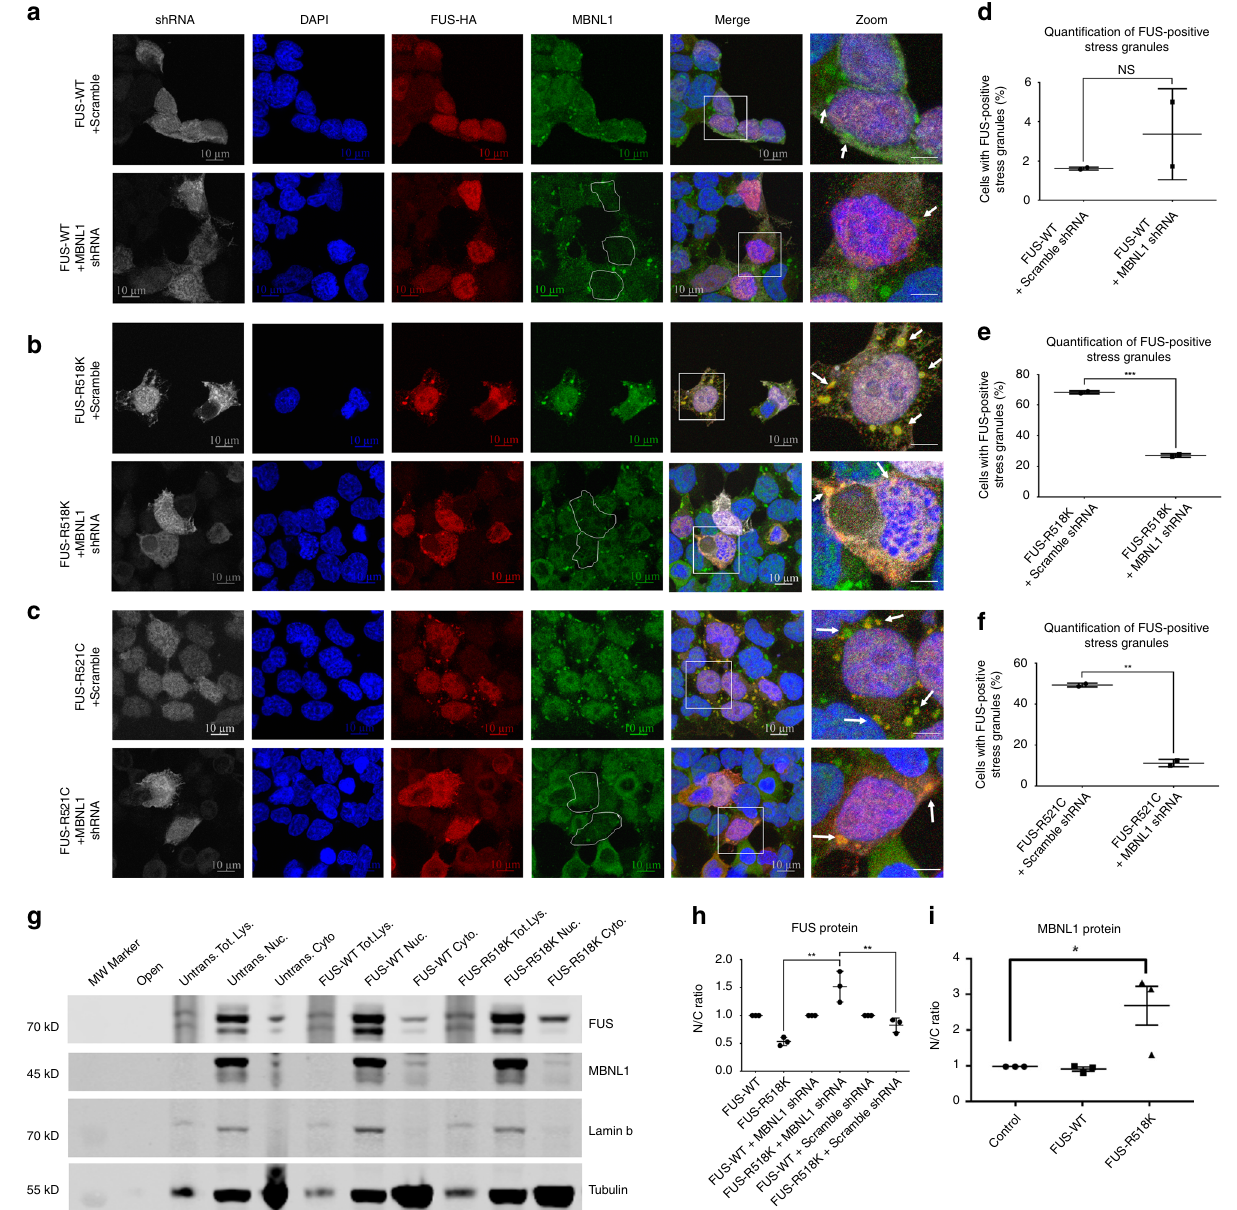
Fig. 3 MBNL1 KD reduces mutant FUS mislocalization and incorporation into SGs. HEK293T cells were co-transfected with the indicated FUS constructs (wild-type, R518K, or R521C) and either MBNL1 or scrambled shRNA and treated with sodium arsenite. Cellular distributions of FUS, MBNL1, and the presence of SGs were assessed by confocal microscopy. a – c Representative confocal images showing FUS and MBNL1 distributions in HEK293T cells. White outlines in the MBNL1 column indicate representative MBNL1 shRNA-transfected cells with reduced MBNL1 signal. White boxes indicate the areas shown in the last column. White arrows indicate representative stress granules. Scale bars = 10 µ m in columns 1 – 5; scale bars = 5 µ m in the last column. d – f Quanti fi cation of the percentage of cells with FUS-positive SGs con fi rms that depletion of endogenous MBNL1 signi fi cantly reduces mutant FUS integration into SGs (one graph per FUS group; N > 20 cells). Statistical analyses were determined using two-tailed t tests (*** P = 0.0006, ** P = 0.0014, NS = not signi fi cant). g Representative WB probed for FUS, MBNL1, Lamin B, and tubulin proteins. Unstressed HEK293T cells were transfected with FUS alone (either wild-type or mutant). Cytoplasmic and nuclear fractions of transfected cells were isolated, and levels of the indicated proteins were assessed. Lamin B and tubulin were used as loading controls for the nuclear and cytoplasmic fractions, respectively. (Tot. Lys. = Total Lysates, Nuc. = Nuclear Lysates, Cyto. = Cytoplasmic Lysates). h Nuclear/cytoplasmic ratios (N/C ratios) of FUS constructs. N/C ratios for FUS mutants were normalized to the ratios for wild-type FUS to compare between WBs. FUS protein levels for each fraction were normalized to lamin B for the nuclear fractions and tubulin for the cytoplasmic fractions. Nuclear values were divided by cytoplasmic values to obtain the N/C ratios. No statistically signi fi cant differences were observed between cells expressing mutant FUS alone and cells co-transfected with scrambled shRNA. i N/C ratios of MBNL1 in HEK293T cells expressing FUS. One- way ANOVA was performed to determine statistical signi fi cance in h using Tukey ’ s multiple comparisons test and in i using Dunnett ’ s multiple comparisons test (** P = 0.0015, NS = not signi fi